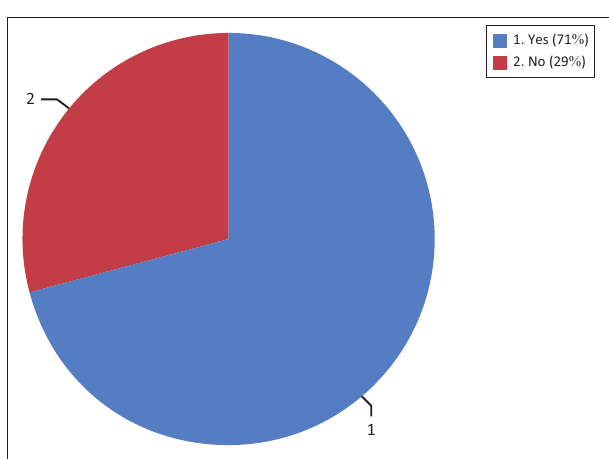
FIGURE 5: Graph presenting percentage of parents who received information from paediatric oncologists ( n =